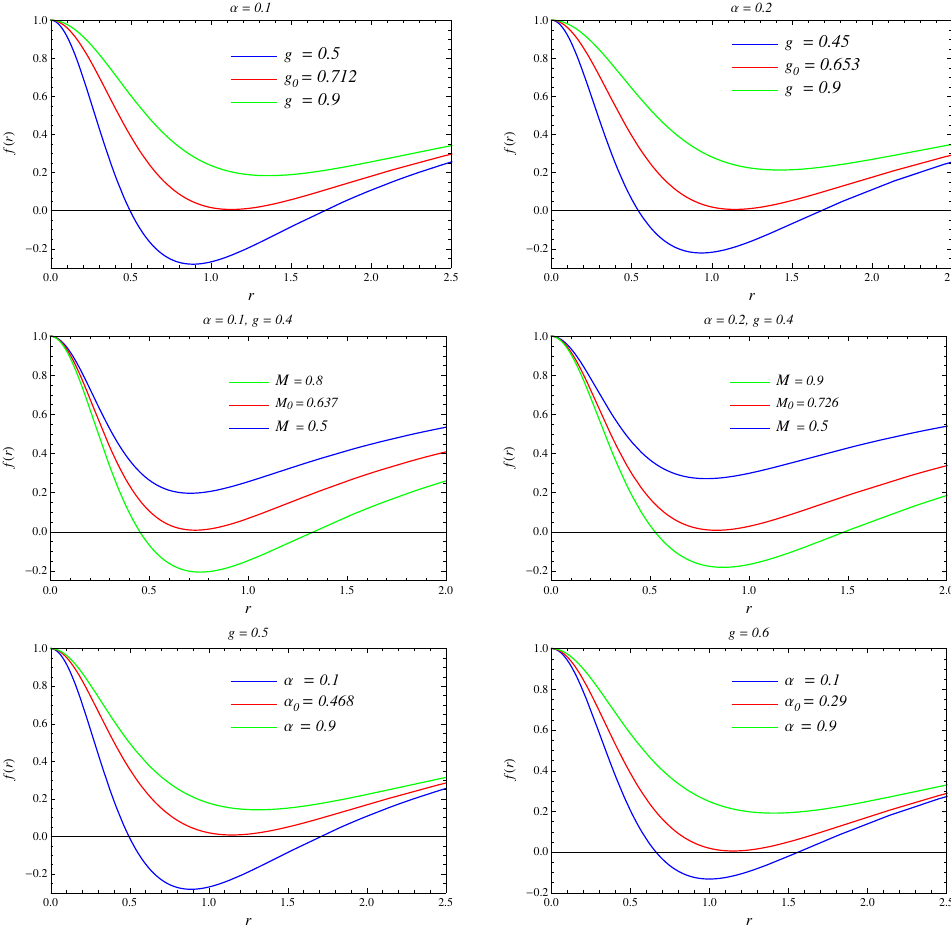
Figure 1. Metric function f ( r ) vs r for Bardeen black holes for various values of